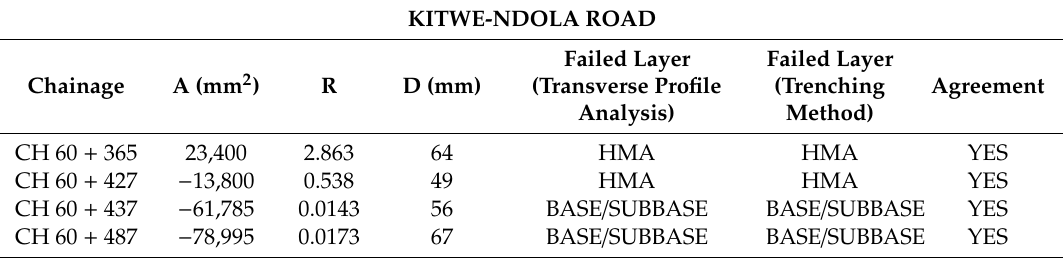
Table 3. Comparison of trench measurements vs. profile